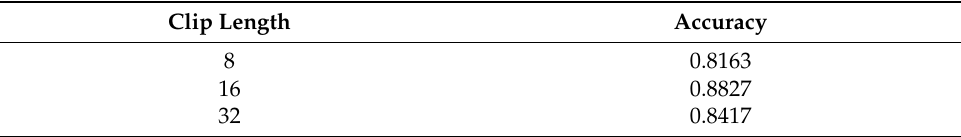
Table 9. Ablation study varying the number of frames per tube. We report the classification accuracy on the RWF-2000 validation set.